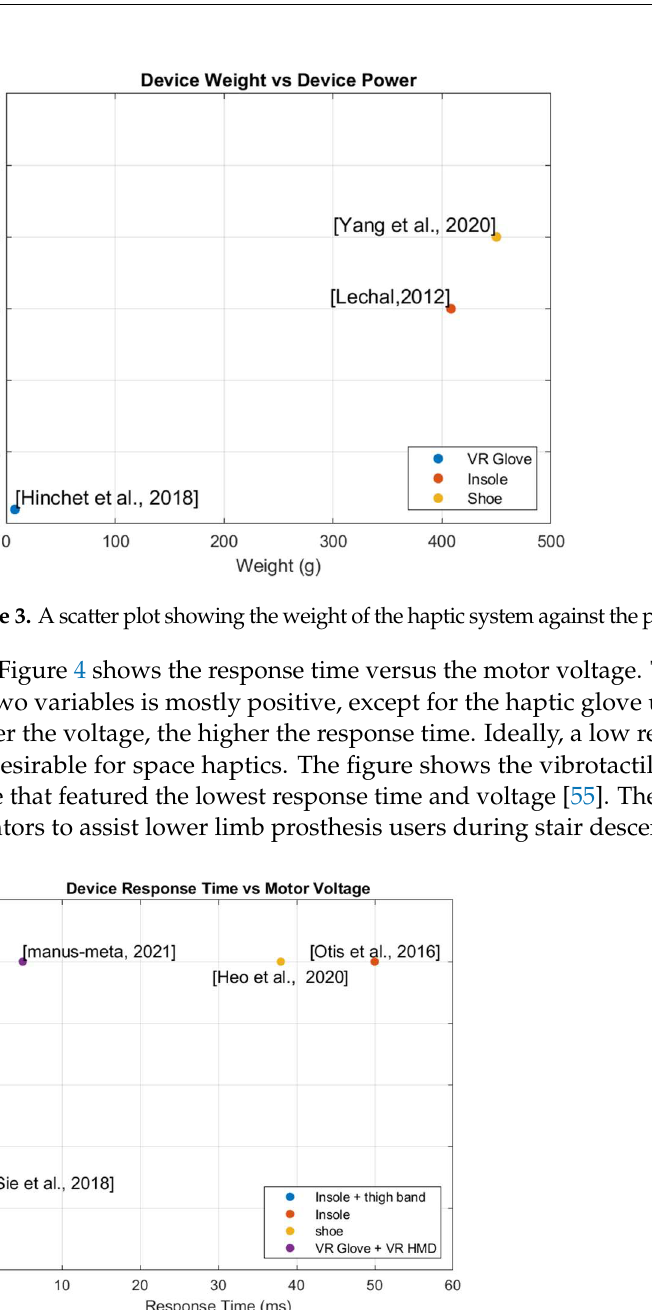
actuator to simulate the material properties of the ground [65], whereas the other study featured a haptic system that used vibrotactile haptics in a shoe insole